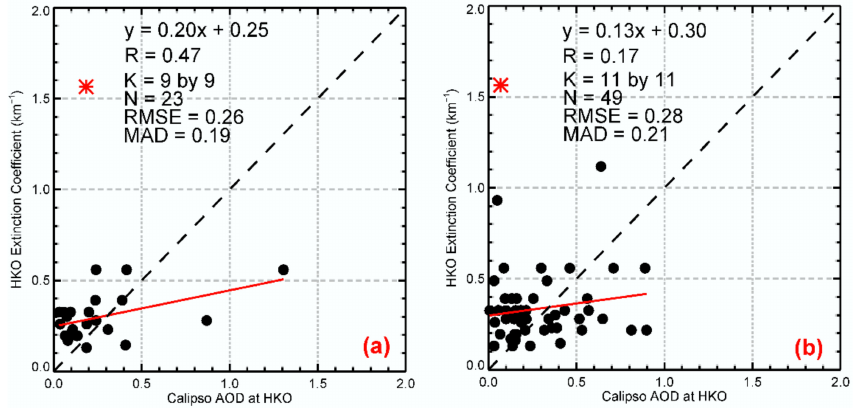
Figure 4. Correlation of Extinction Coefficient at HKO with CALIOP AOD (5 km product at 532 nm) for kernel windows of ( a ) 9 by 9 and ( b ) 11 by 11. There is no valid AOD retrieval for kernel windows of 1 by 1 to 7 by 7. *—potential outlier in the data. Lines as described in Figure 2.